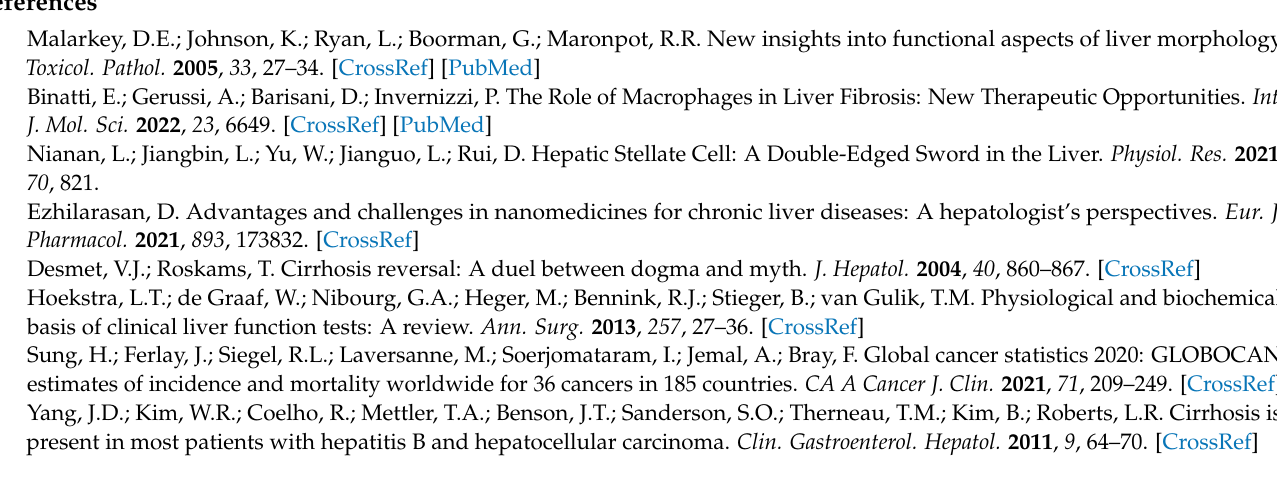
100 nm scale. (B) Image of MNPs at 50 nm scale. Figure S2: Hydrodynamic size obtained by the dynamic light scattering experiment. Figure S3: (A) Magnetization curve of MNPs in a fluid sample and a powder sample (B) acquired by the VSM experiment. Figure S4: EDS quantification of the MNPs composition quantification. (A) MNPs sample used, in which the numbers (1, 2, and 3) represent the studied region. (B) Representative example of EDS signal acquired and its quantification (region 2 of the MNPs image). Figure S5. X-ray diffractogram of Cit-MnFe 2 O 4 MNPs. Figure S6: FTIR measurements of citrate and the Cit-MnFe 2 O 4